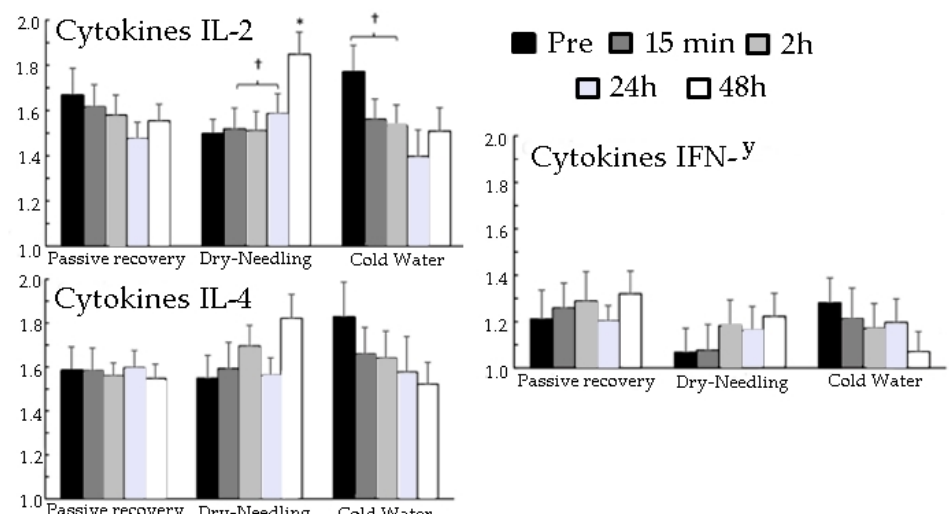
Figure 2. Maximal isometric force measured in the bench press before and after 15 min, 2 h, 24 h, and 48 h after an exercise induces muscle damage and a recovery (passive, dry-needling, or cold- water immersion) protocol after 15 min, 24 h, and 48 h after exercise-induced muscle damage and a recovery protocol. * indicates a significant difference with all other test moments ( p < 0.05). † indi- cates a significant difference between these two test moments ( p < 0.05).